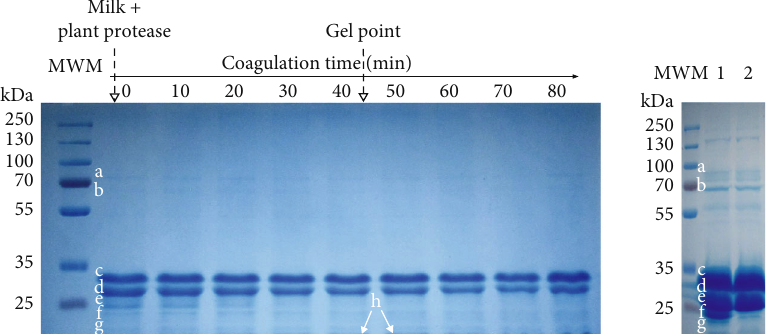
-caseins, e= κ -caseins, f= γ - s1